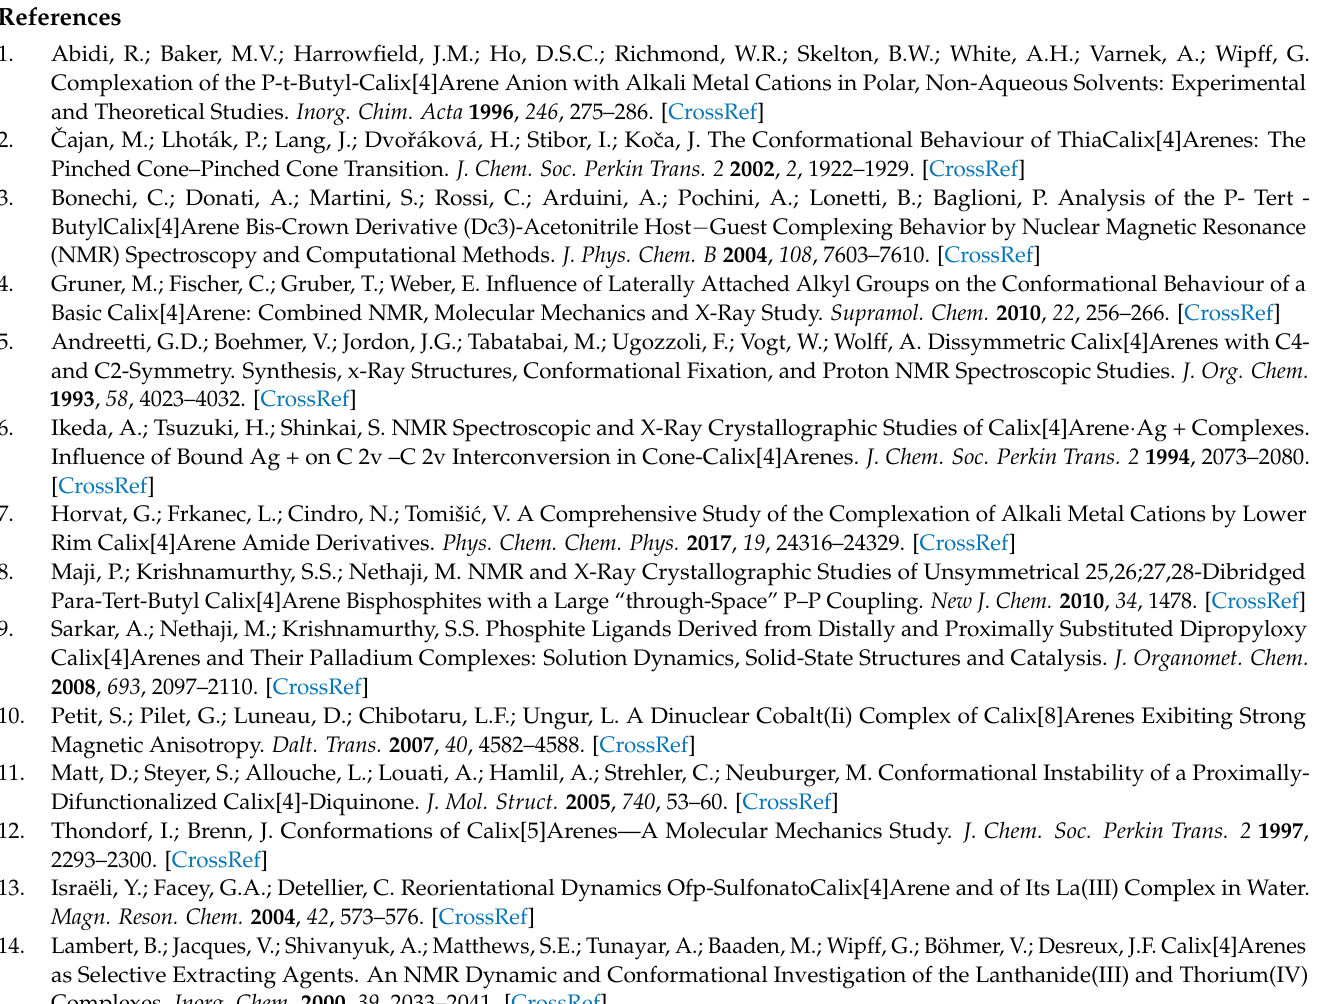
Figure S3: Temperature dependence of the chemical shifts of t-Bu signal of complex (I). The solvent is